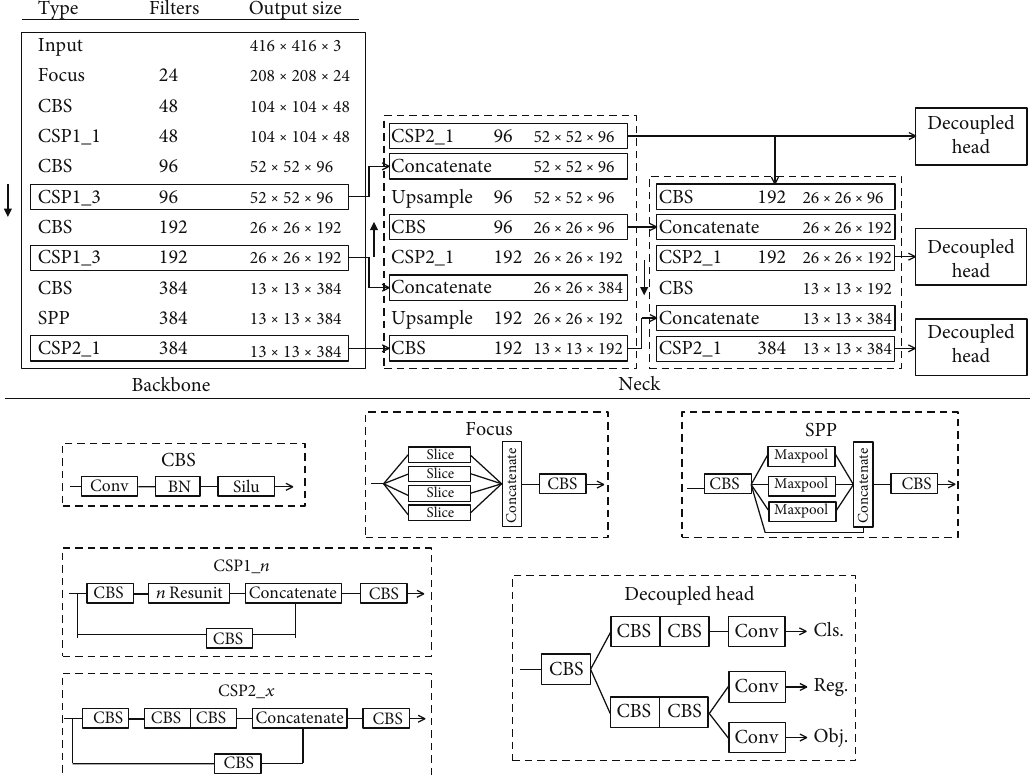
Figure 2: Network structure of aviation rivet classi fi cation and anomaly detection algorithm based on deep